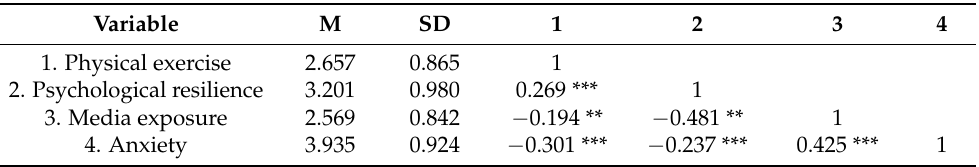
Table 4. Correlations and descriptive statistics of the main variables.